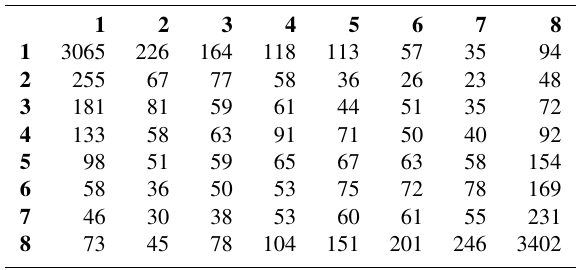
Table 3. Co-occurrence matrix after the image pre-processing (Fig. 6b) for the first neighbour (n = 1 ) and for a cell pair aligned with the mean wind and oriented in the same direction (azimuth ϕ = 0 ◦